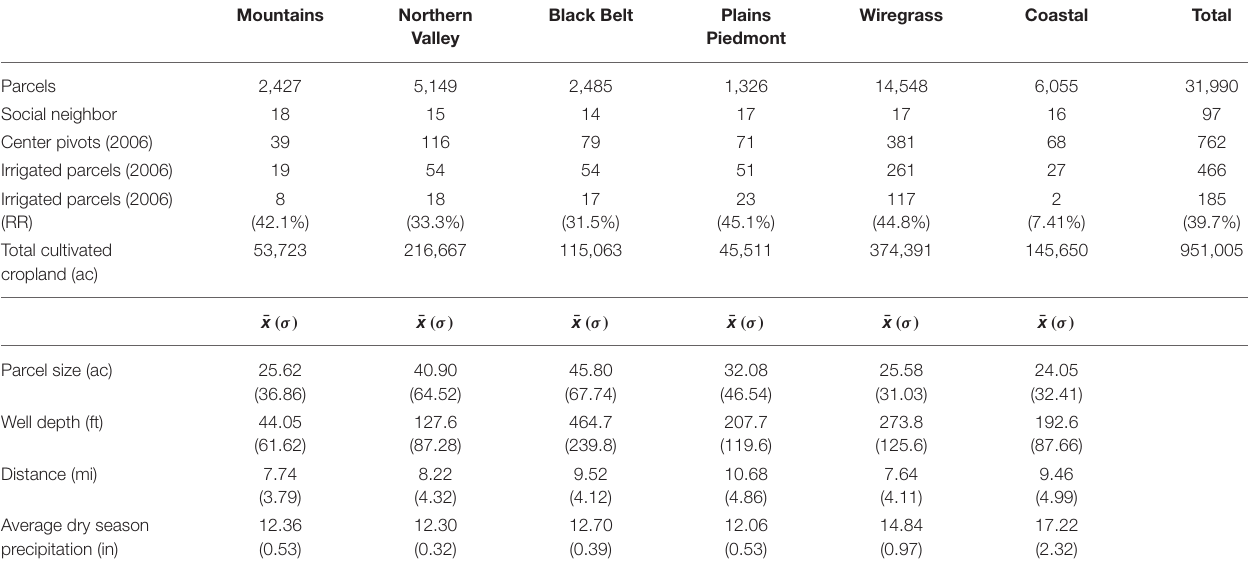
TABLE 1 | Descriptive statistics of each region’s parcel characteristics, total cropland, and extent of irrigation at the start of the study period in 2006. Mountains Northern Black Belt Plains Wiregrass Valley Piedmont